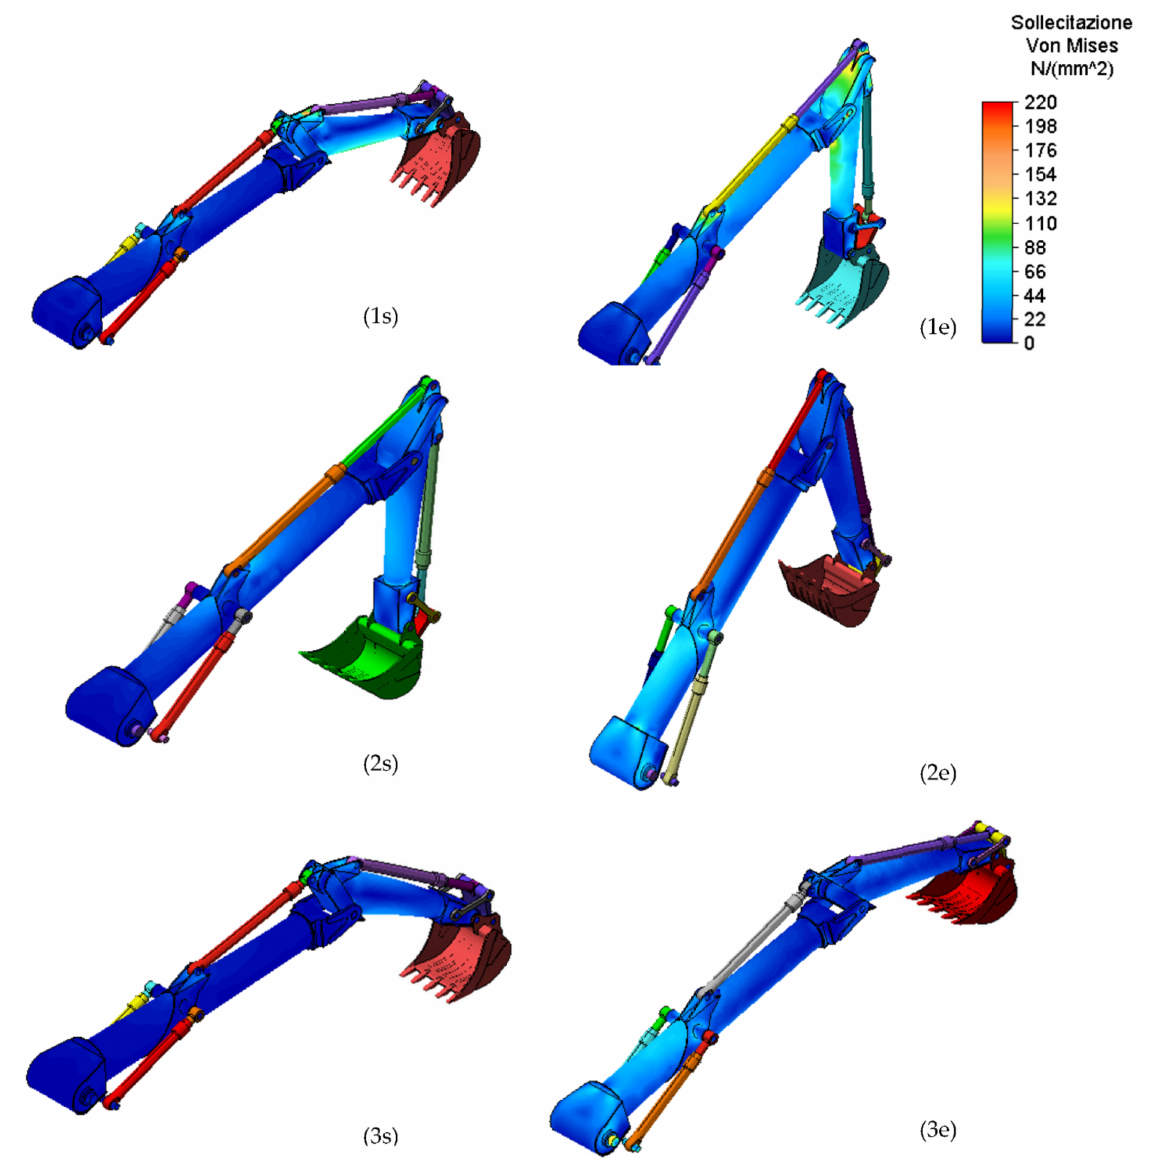
Figure 8. Maximum Von Mises Stress, for stick and boom, for the work conditions: start ( s ) and end ( e ) movement for the 1, 2, and 3 load